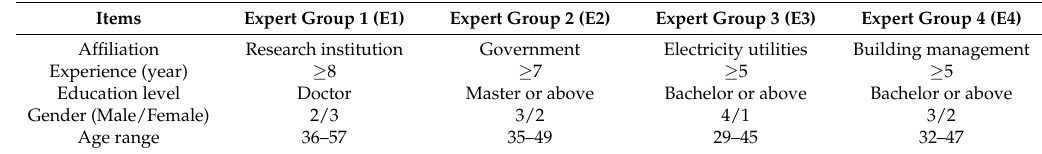
Table 5. Expert group characteristics description.